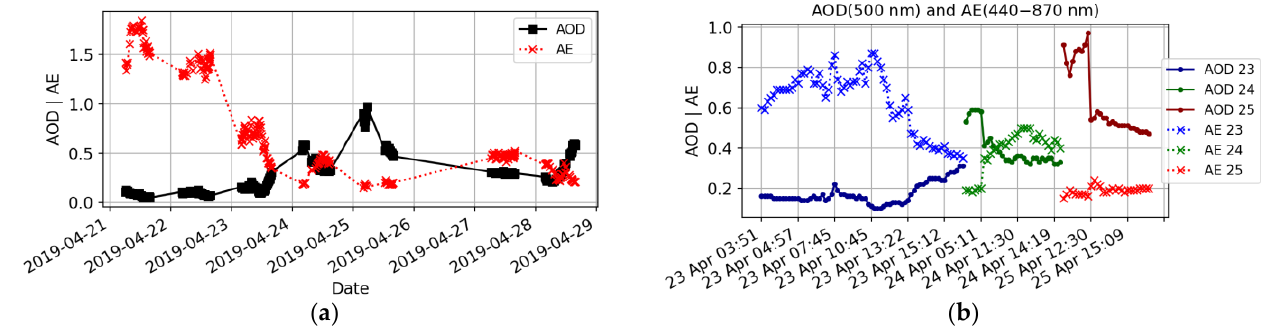
Figure 3. Changes in aerosol optical depth (AOD 500 nm) and Ångström exponent (AE 470–870 nm) during ( a ) the 21–29 April period and ( b ) day time of 23–25 April 2019, Nicosia, Cyprus. Data level 2.0.